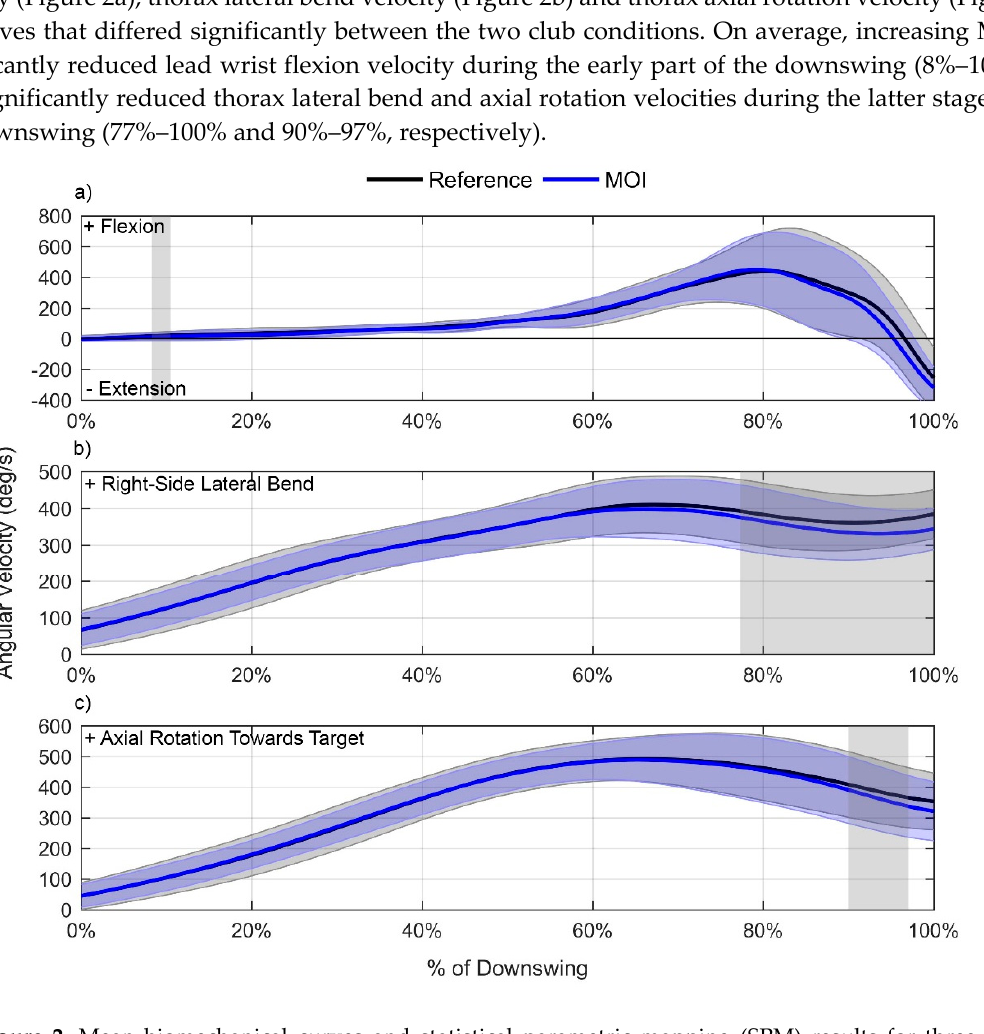
Figure 2. Mean biomechanical curves and statistical parametric mapping (SPM) results for three biomechanical variables: ( a ) lead wrist flexion/extension velocity; ( b ) thorax lateral bend velocity; ( c ) thorax axial rotation velocity. Shaded regions represent a significant difference ( p < 0.05) between club